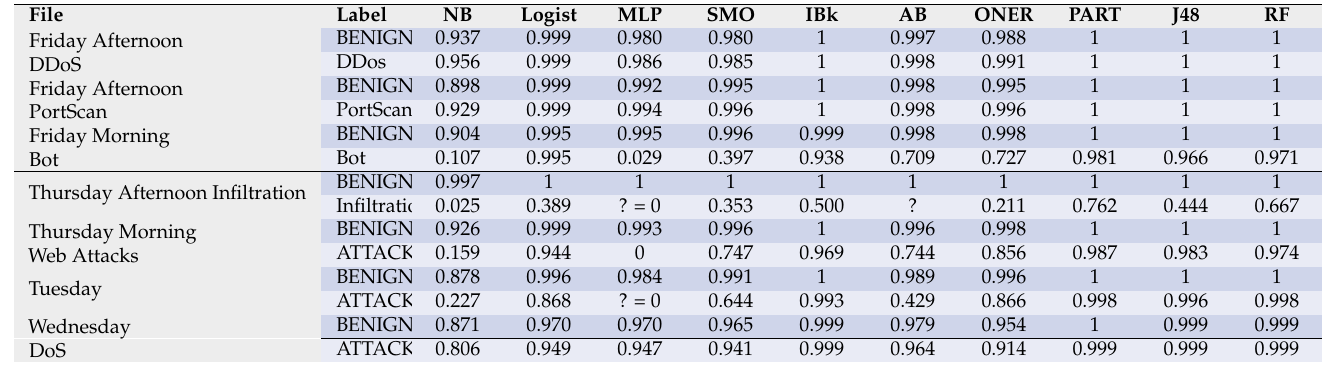
that have significantly reduced their time. Table 13. F1 performance results obtained for each dataset file in binary classification.